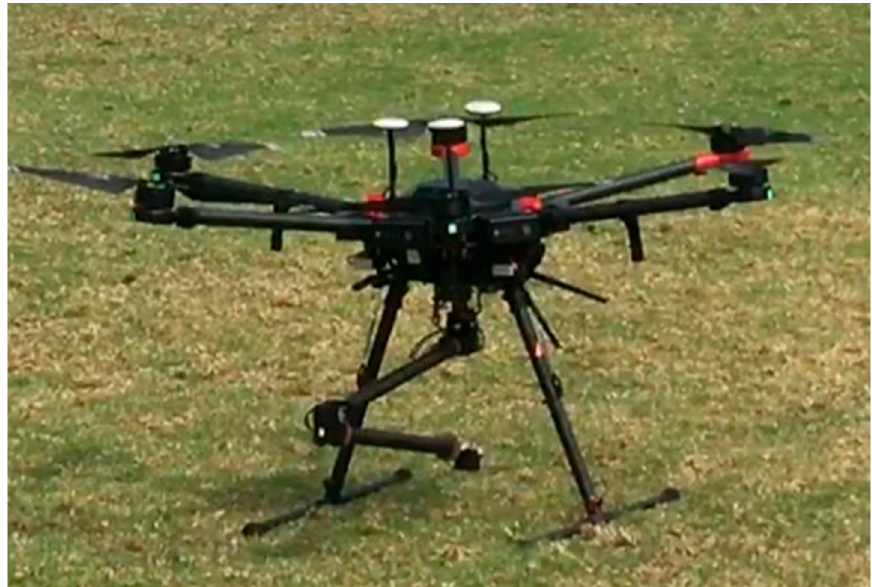
Figure 6. Aerial manipulator robot used in the in experimentation.